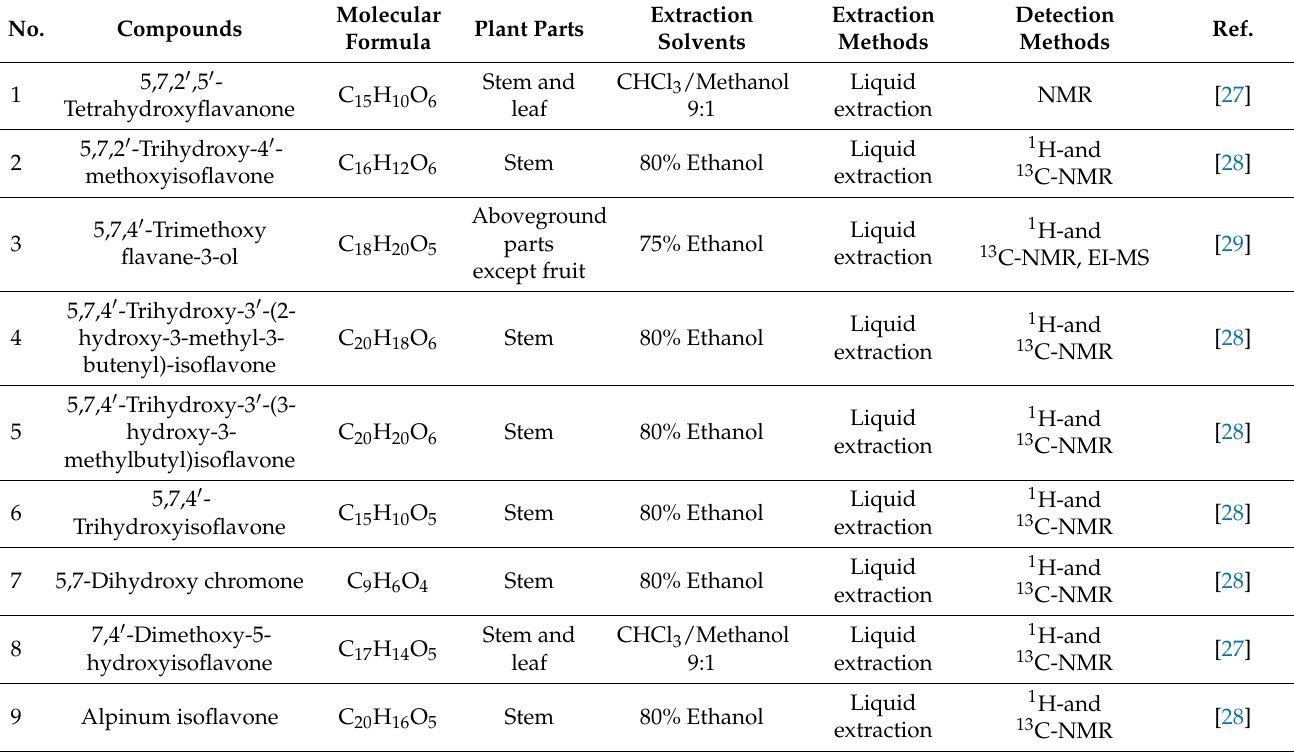
Table 1. Flavonoid compounds found in Ficus pumila L.